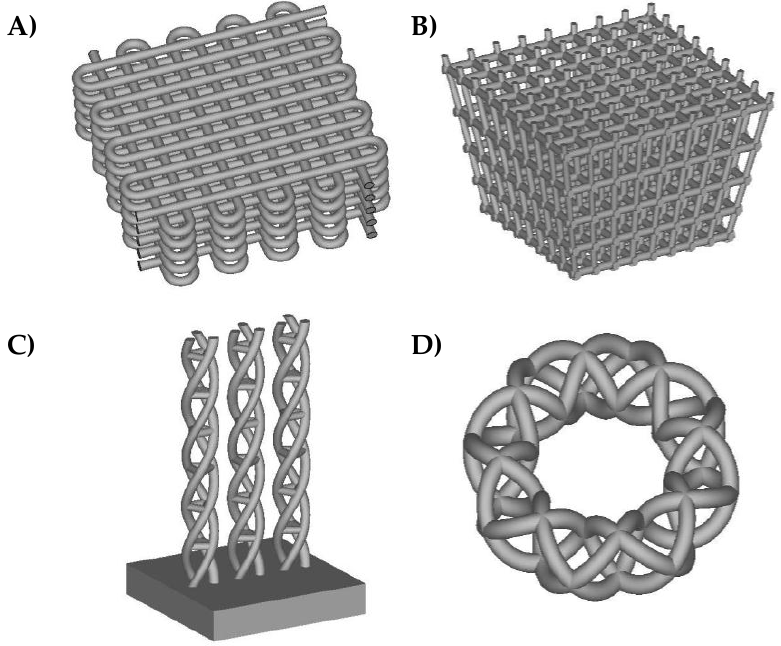
Figure 1. Computer-aided designs of lattice structures and frameworks, based on common tissue engineering scaffold geometries, for acting as supports for knitted carbon fibers. ( A ) Scaffold with porous geometry typically obtained by fused-deposition modeling; ( B ) Scaffold with functional gradient of porosity as potential bone repair model; ( C ) Tubular scaffold aimed at ligament and tendon repair; ( D ) Annular scaffold for sphincter tissue engineering.